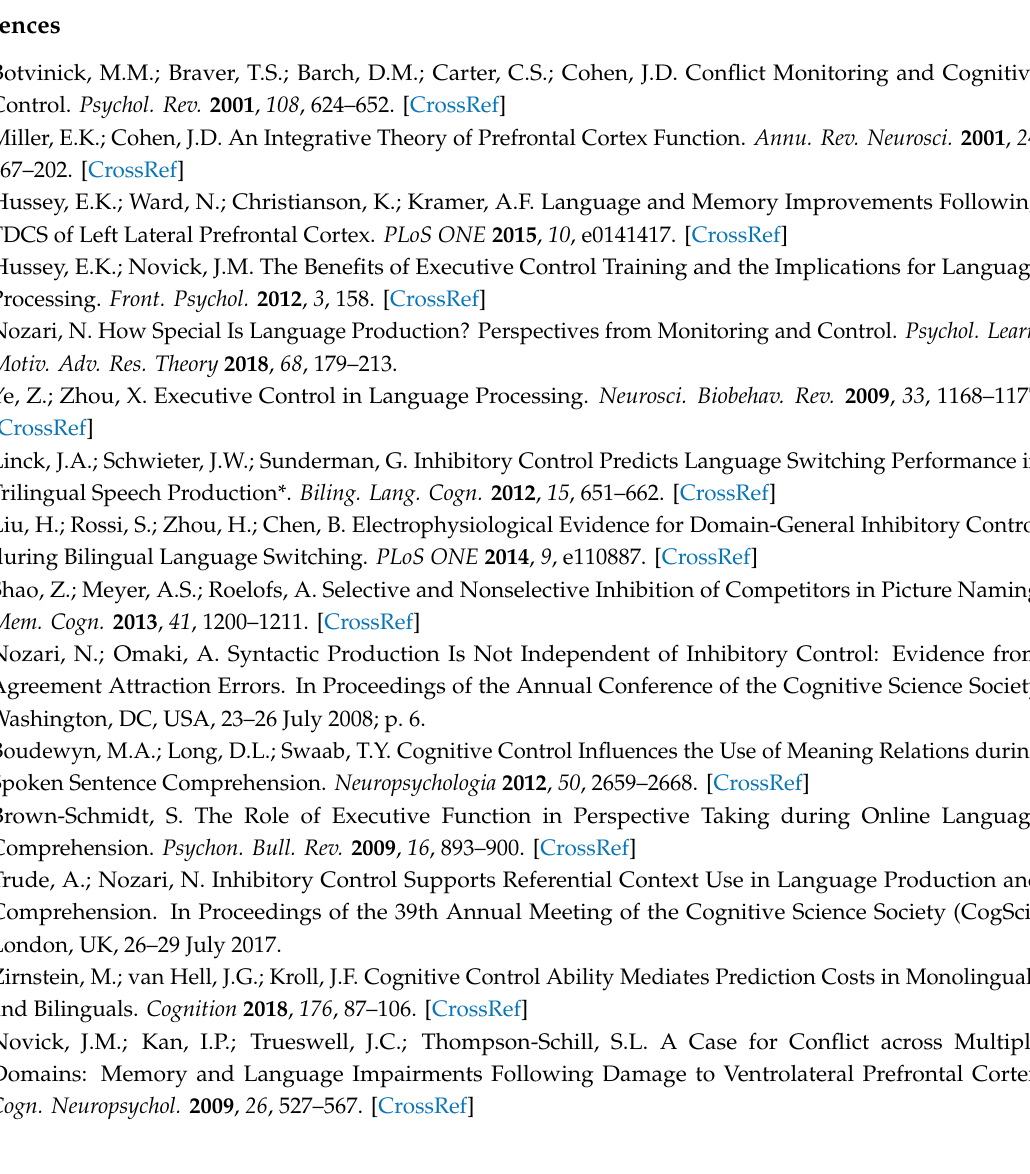
goal over time as a function of ambiguity. Higher values on the y-axis indicate more looks to the incorrect goal. Colored error bars indicate 95% confidence intervals, Figure S4: Mean proportion of fixations on the incorrect goal over time as a function of ambiguity and preceding Stroop trial type. Colored error bars indicate 95% confidence intervals, Table S1: Summary of mixed model analysis for correct goal fixations, Table S2: Summary of mixed model analysis for incorrect goal fixations, Table S3: Summary of mixed model analysis for correct goal fixations by experimental half, Table S4: Summary of mixed model analysis for incorrect goal fixations by experimental half, Table S5: Summary of mixed model analysis examining the e ff ect of working memory on incorrect goal fixations. The stimuli materials have been made publicly available by Hsu and Novick